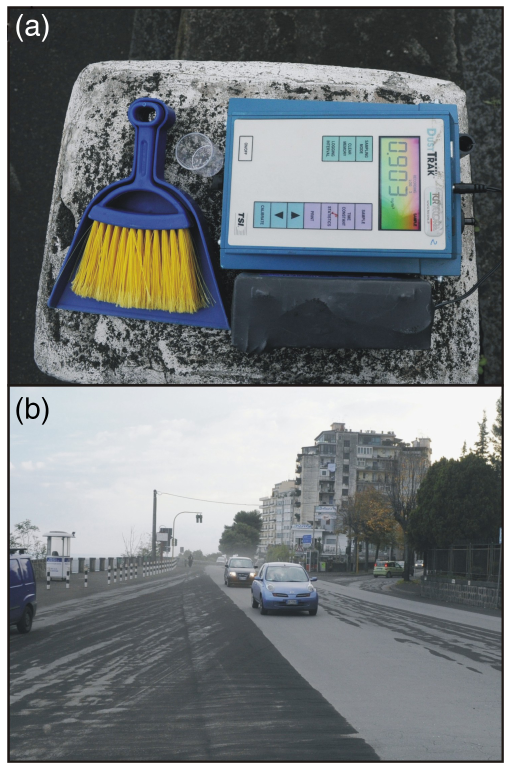
Figure 3. PM 10 measurement carried out on 15 November 2011 in Acireale at site 2 (SS114 road): (a) DustTrak ™ in operation; the dis- play shows the averaged reading over the previous 10s; (b) transit of cars at the